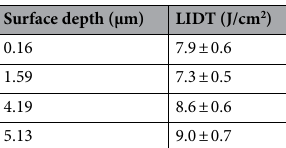
Table 4. The 1-on-1 LIDT’s of the four FJP-finished surfaces generated in this study.